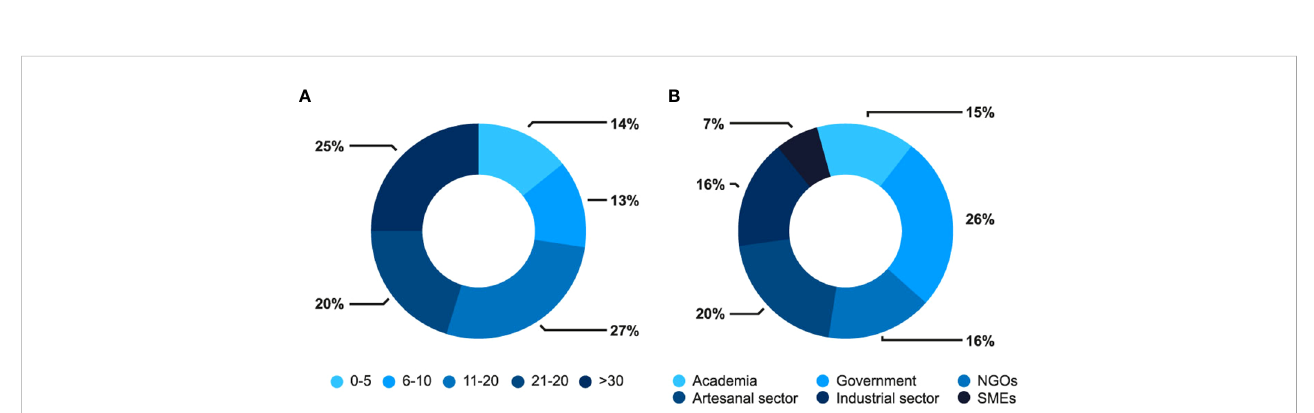
FIGURE 1 (A) Respondents by years of experience in the fi sheries industry and (B) Respondents by